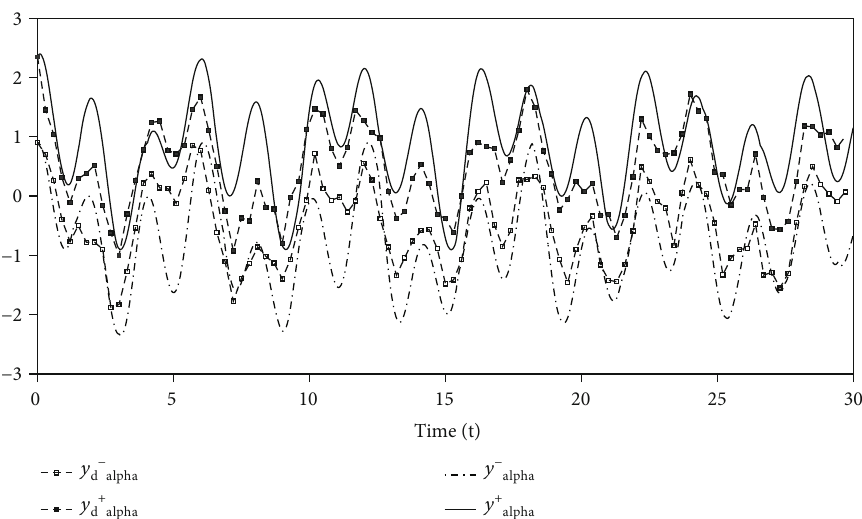
− t Þ , y data+ t Þ(cid:2) and the α − cut of solution of Problem (29), i.e., ½ y − data α ð α ð